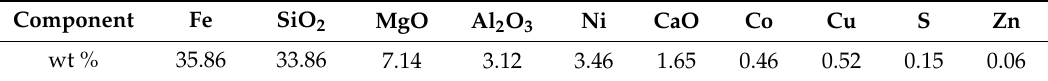
Table 1. Elemental composition of the nickel flash smelting slag mixture.